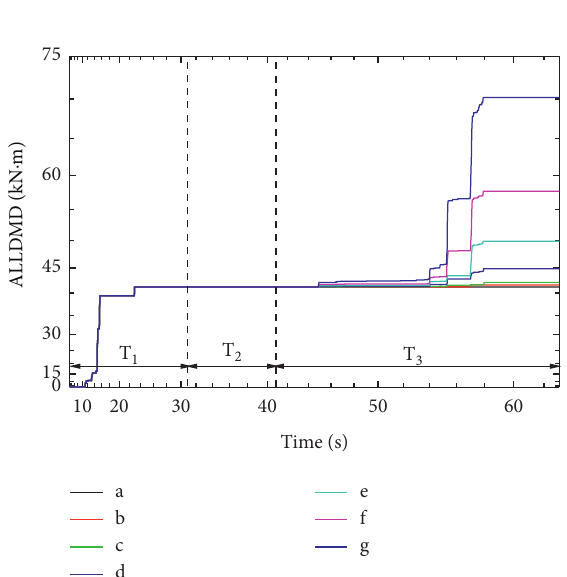
Figure 10: Plastic dissipated energy.